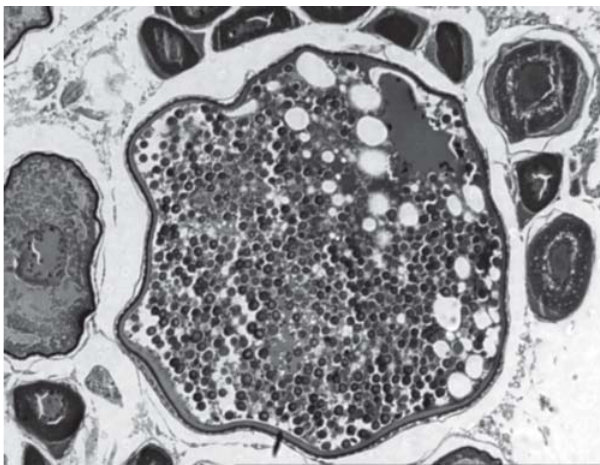
Fig. 7. Merluccius hubbsi: oocyte with nuclear migration (1.5mm length field).